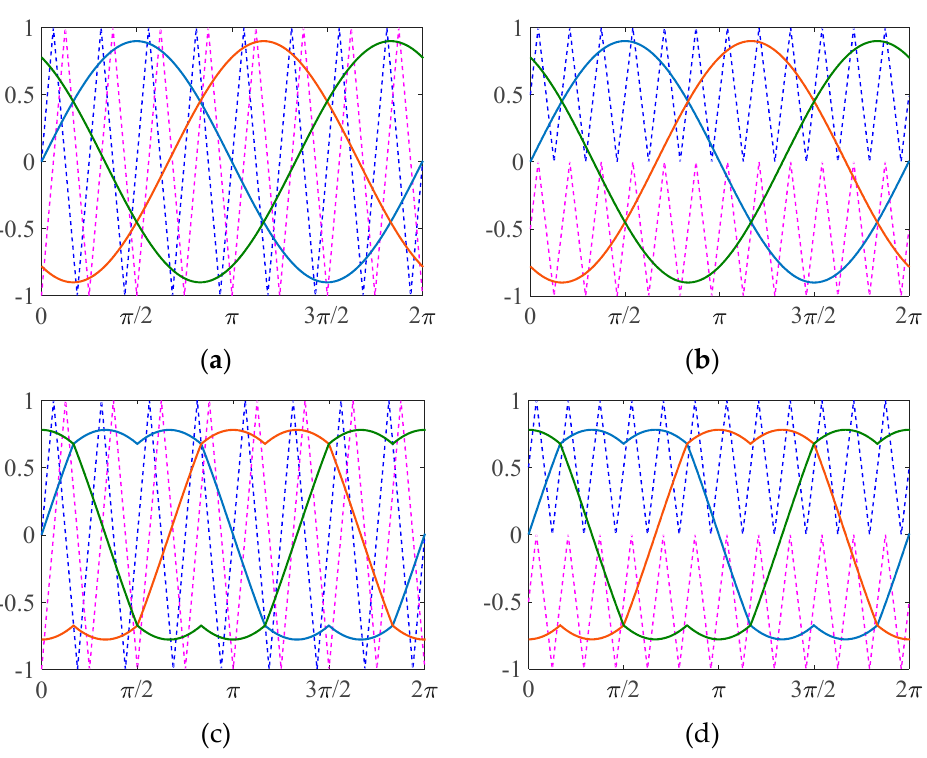
Figure 6. Carrier-disposition-based modulation schemes: ( a ) Sinusoidal Phase Shifted—SPS; ( b ) Sinusoidal Suppressed Carrier Arrangement Modulation—SCAMOD; ( c ) Switching Frequency Optimal Phase Shifted—SFOPS; ( d ) Switching Frequency Optimal Suppressed Carrier Arrangement Modulation—SFOSCAMOD.